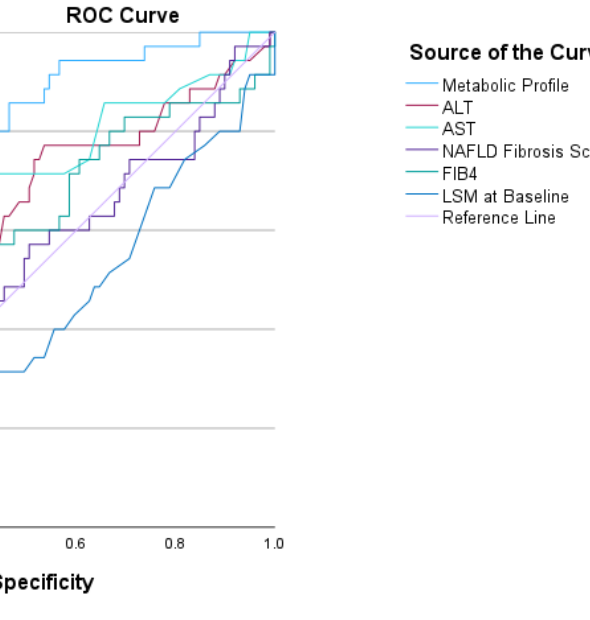
Figure 1. Diagnostic performance of metabolic profile for predicting fibrosis progression compared to ALT, AST, NAFLD fibrosis score, FIB-4 and LSM. Abbreviations: ALT, alanine aminotransferase; AST, aspartate aminotransferase; LSM: liver stiffness measurement. Table 3. Multivariate analysis of metabolites independently associated with fibrosis